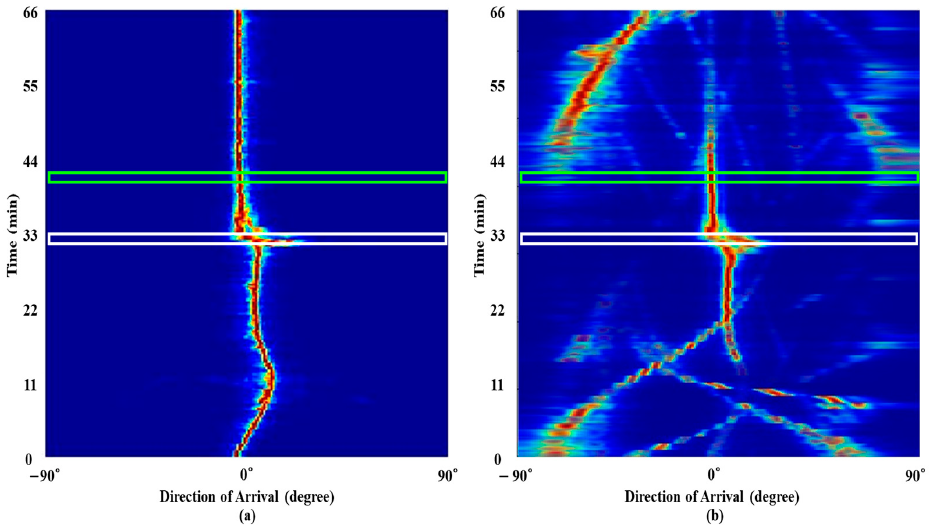
Figure 4. The ship tracks from conventional beamforming results using ( a ) the pilot frequency; ( b ) the frequency components from the fishing boats and the experimental ship.